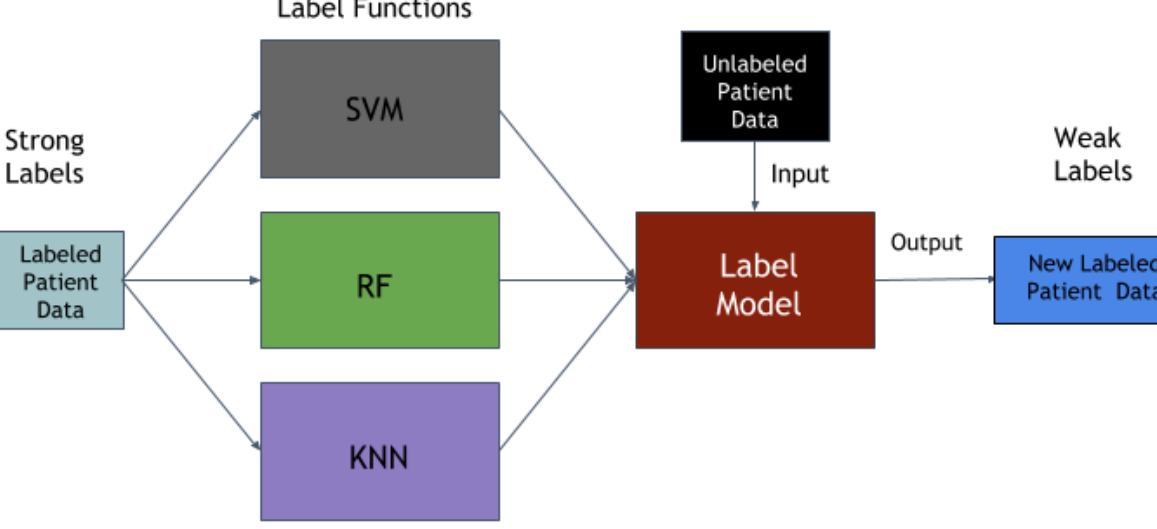
Figure 1. Snorkel labeling architecture. KNN: k-nearest neighbor; RF: random forest; SVM: support vector